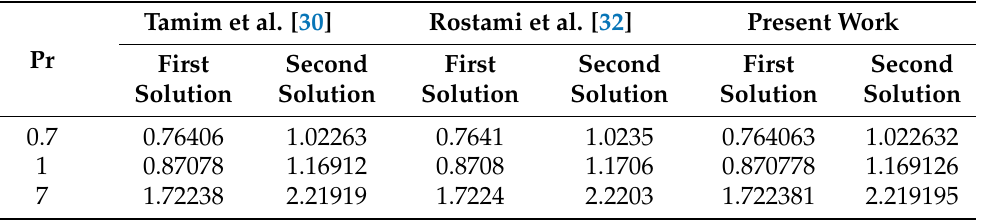
Table 4. Comparison values of − θ (cid:48) ( 0 ) for multiple values of Prandtl number when Rd = S = ϕ 1 = ϕ 2 = 0 and λ =